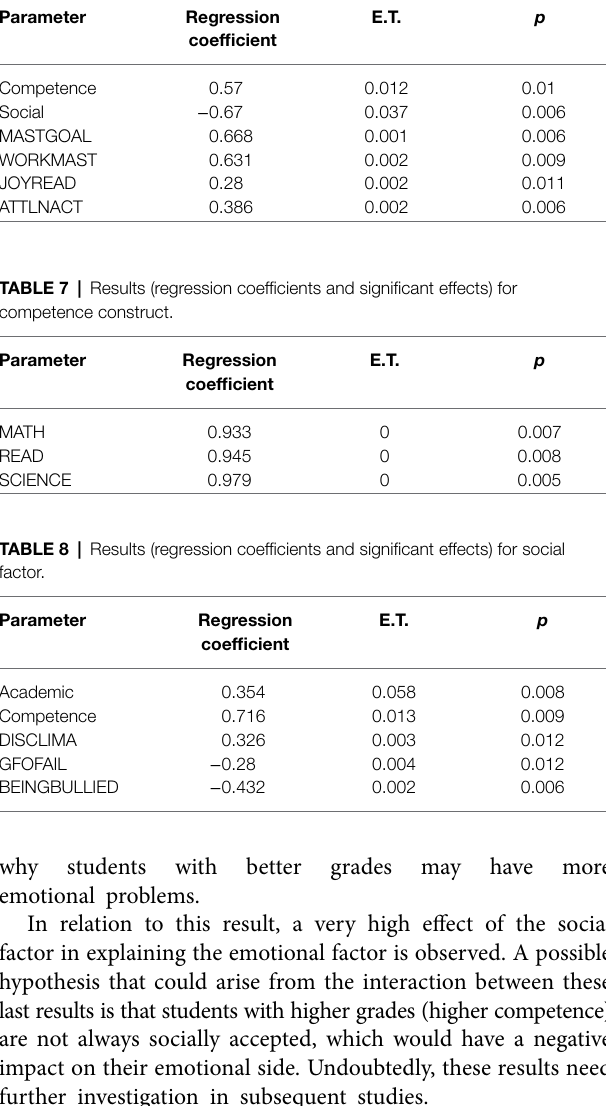
TABLE 3 | Results (regression coefficients and significant effects) for the second independent variable: time spent in Internet during a typical weekend (Time_ weekend).